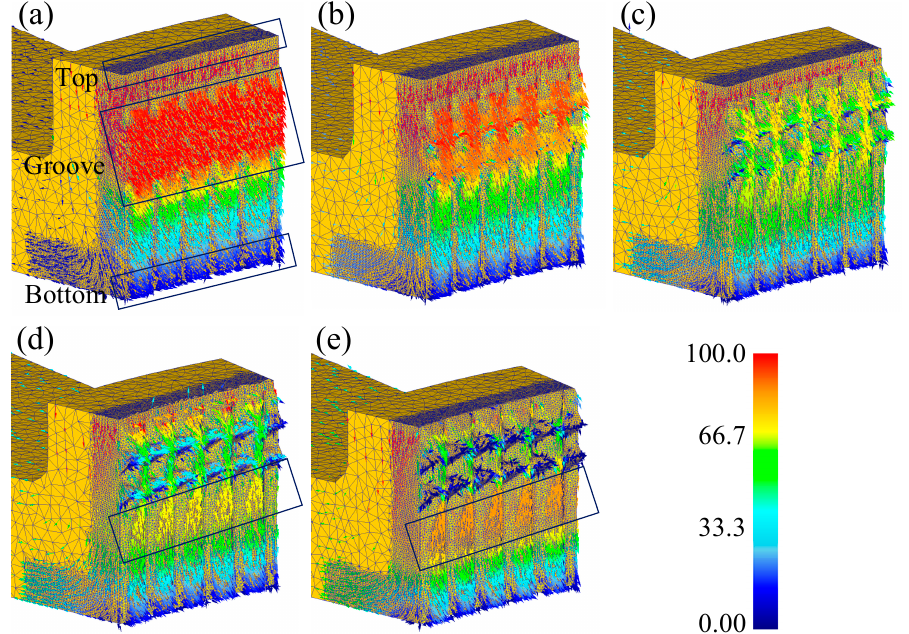
Figure 9. Distribution of velocity (mm / s) (Case 2): ( a ) stroke 0.100 mm; ( b ) stroke 0.260 mm; ( c ) stroke 0.495 mm; ( d ) stroke 0.755 mm; ( e ) stroke 1.000 mm.